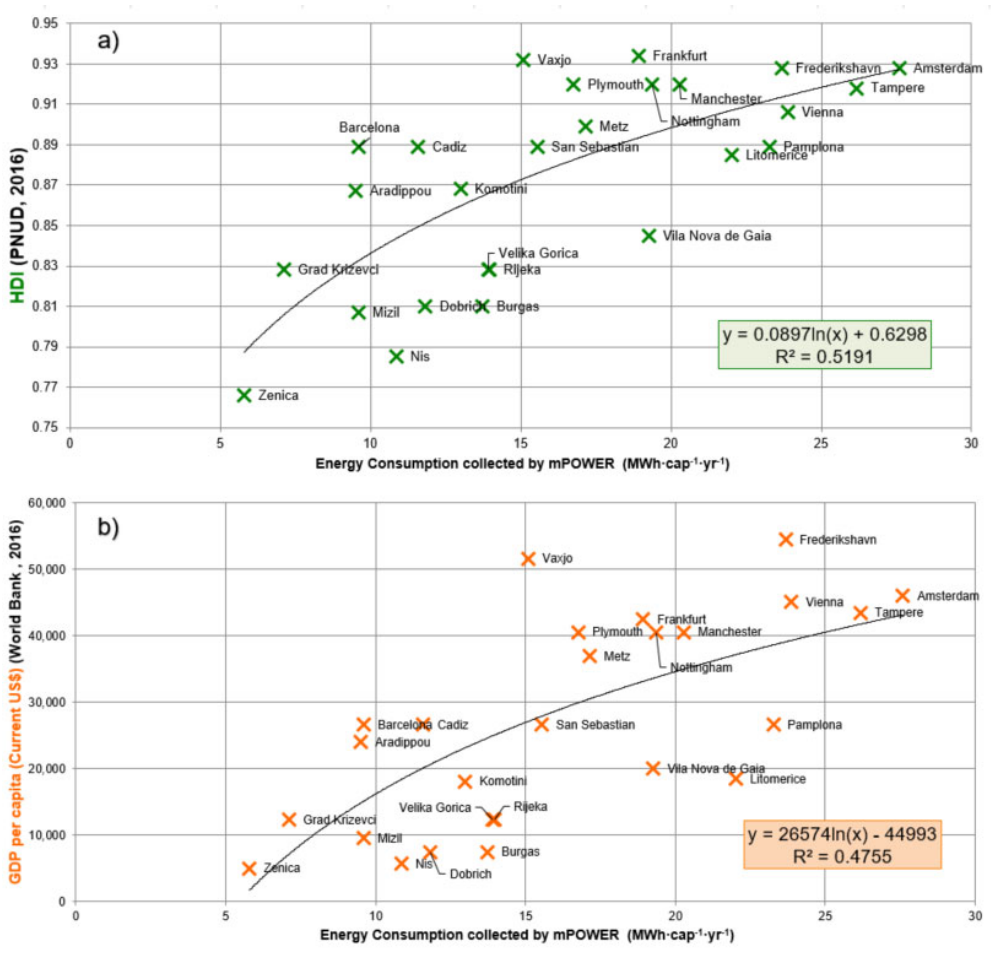
Figure 8. Energy consumption of each city compared to the corresponding national Human Development Index (HDI) (a) and the national Gross Domestic Product (GDP) (b).